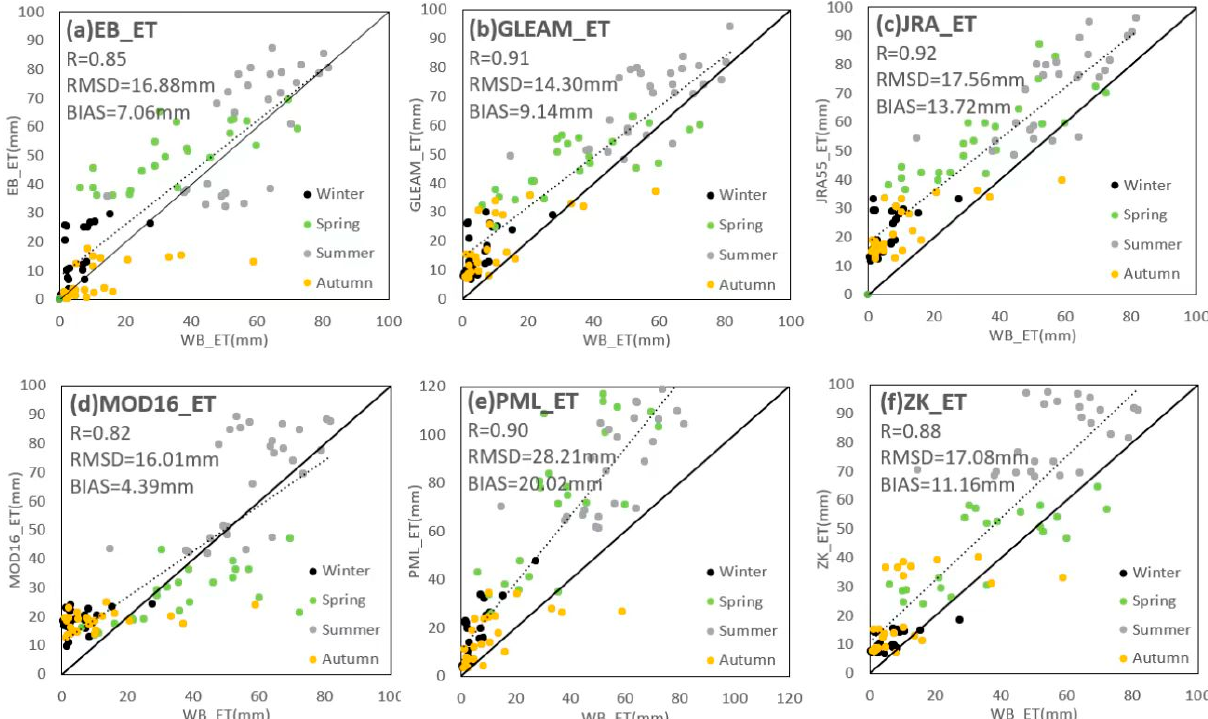
Figure 8. Analytical scatter plots of the monthly ET products for 2003–2012 against the WB_ET.